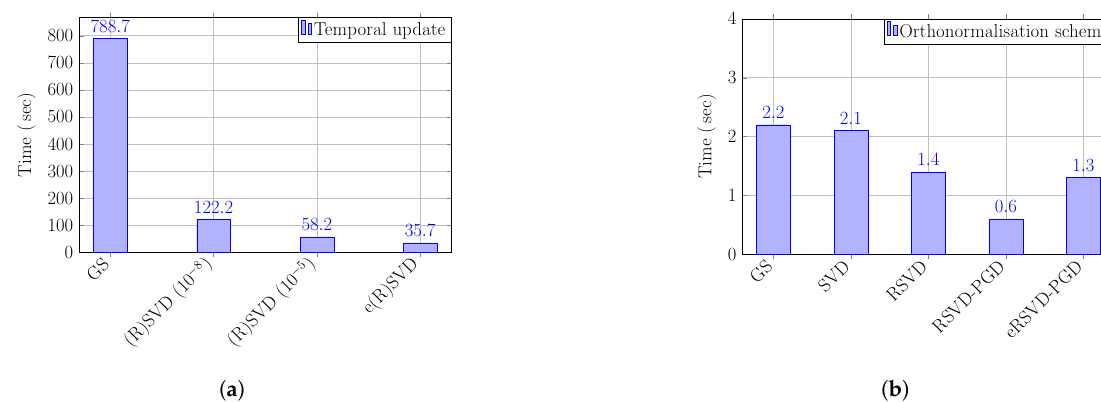
Figure 8. ROB size using different orthonormalisation algorithms. ( a ) number of PGD modes using (R)SVD ( (cid:101) tol = 10 − 5 ); ( b ) number of PGD modes using e(R)SVD.